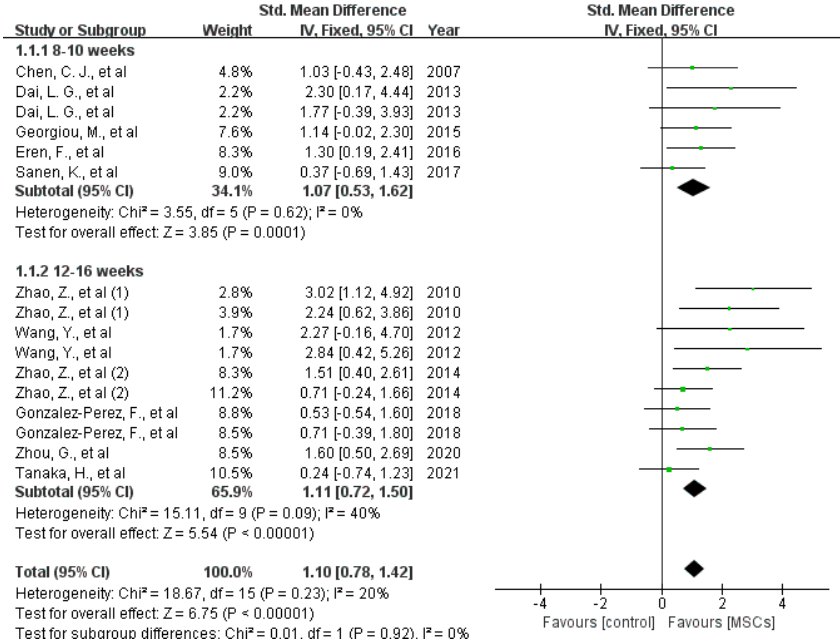
Figure 7. Meta ‐ analysis of the effects of MSCs on axon number (middle and distal parts of the nerve defects) 8–10 weeks and 12–16 weeks after implantation [5,11–36]. Plots on the right ‐ hand side indicate favoring MSCs or MSCs ‐ loaded scaffolds, while plots on the left side indicate favoring placebo ‐ control treatment or blank scaffolds.